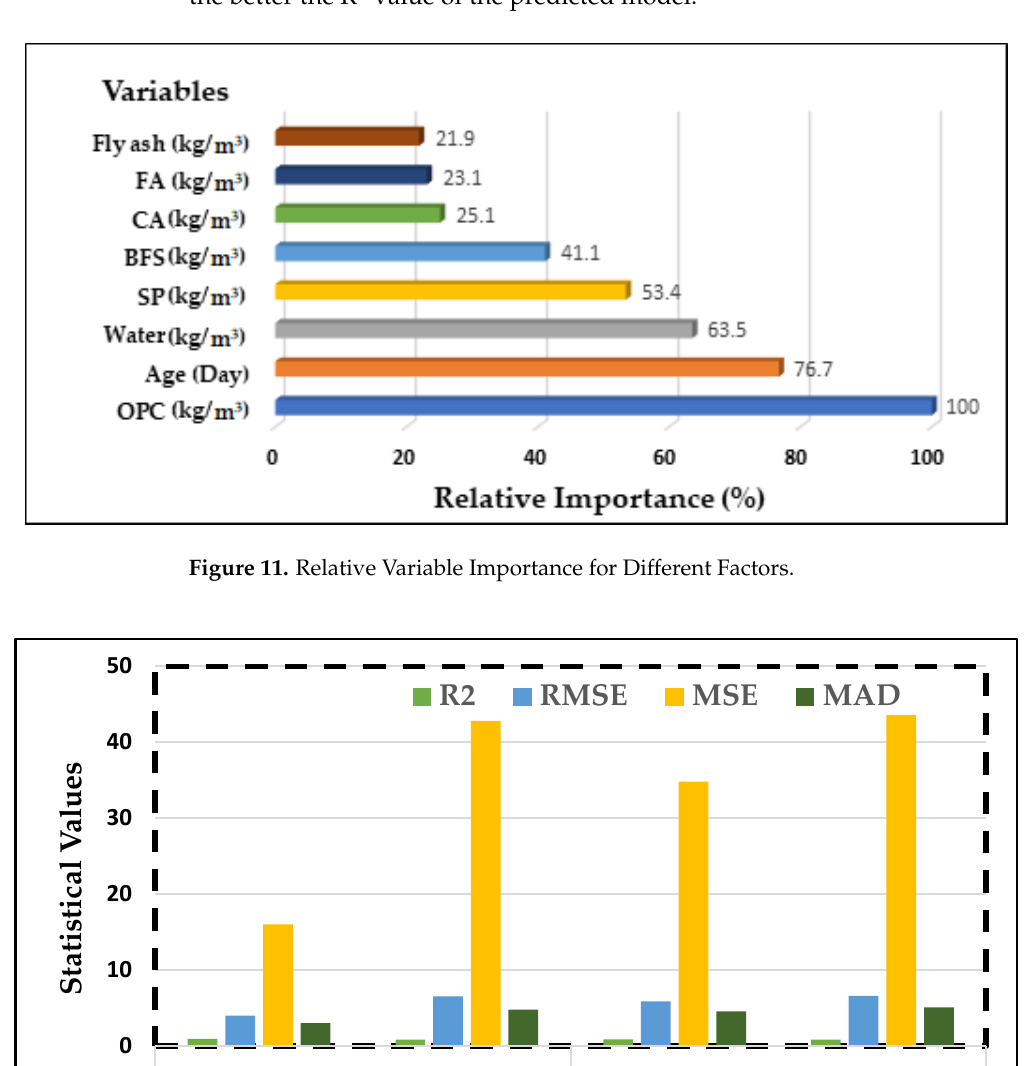
Figure 12. Comparative Analysis of Prediction Using DT and ANNs models.